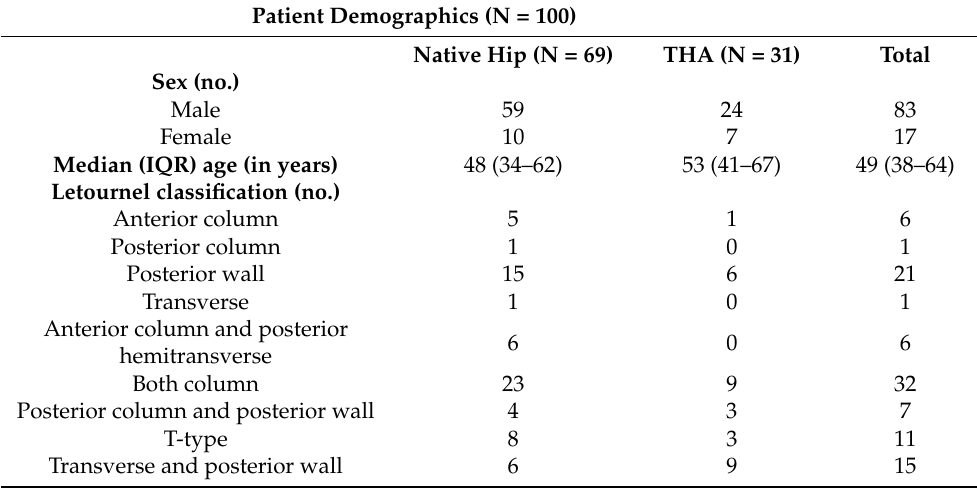
Table 1. Patient characteristics. THA: Total hip